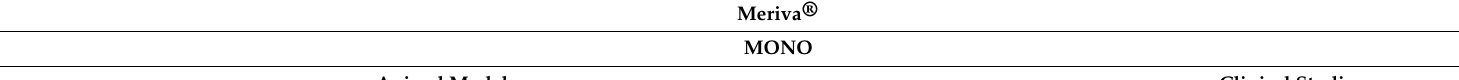
Table 3. E ff ects of Meriva ® obtained in vitro, in vivo and in clinical